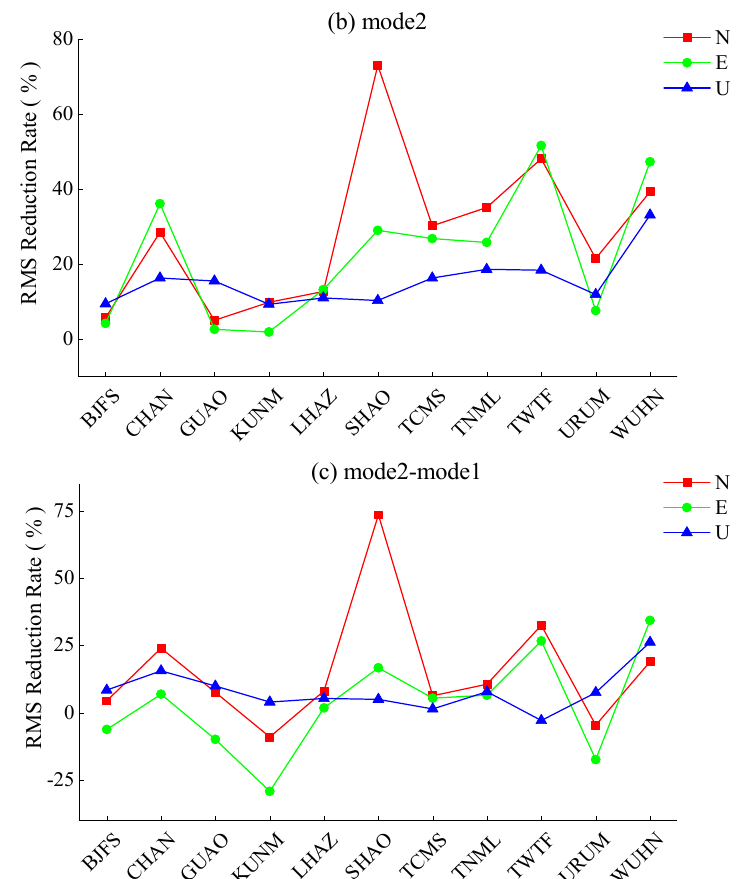
Figure 8. RMS reduction rate of residual time series in Chinese IGS stations. ( a ) shows the RMS reduction rate of residual time series obtained from mode1, and ( b ) shows the RMS reduction rate of residual time series obtained from mode2. ( c ) shows the di ff erence between ( a , b ). Note that the scales of the vertical axis in these figures are di ff erent from each other.